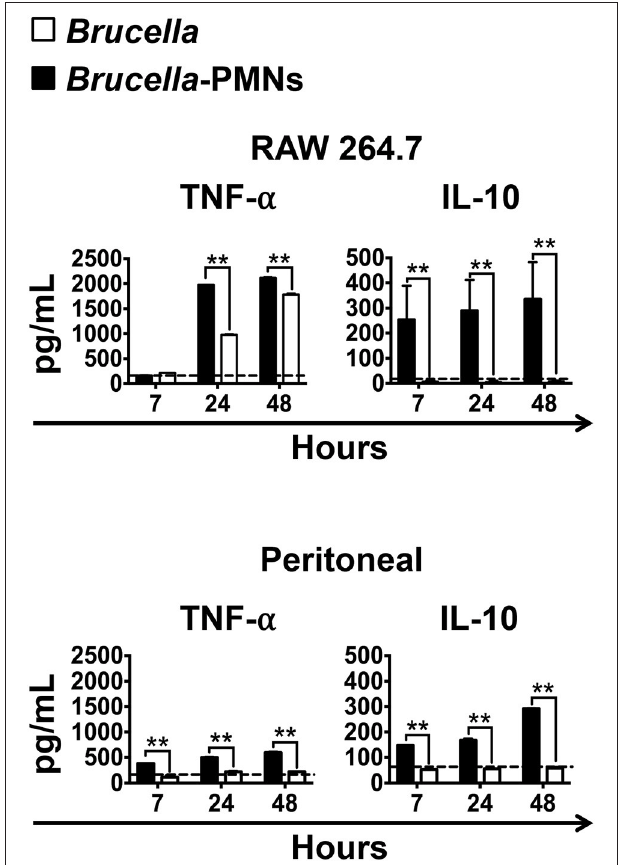
FIGURE 5 | High production of IL-10 and low production of TNF- α in the supernatant of infected M φ s at initial stages of infection. RAW and peritoneal M φ s were infected with B. abortus -RFP (MOI 50) alone or with B. abortus- infected PMNs (MOI 5), and the supernatants collected at different time points. The level of the cytokines was determined by ELISA in the culture supernatants of infected M φ s. Values of p < 0.01 (**) are indicated in relation to M φ s infected with Brucella alone. The backgrounds of the cytokine production by M φ s co-cultivated with non-infected PMNs are indicated by dashed lines. These experiments were repeated at least three